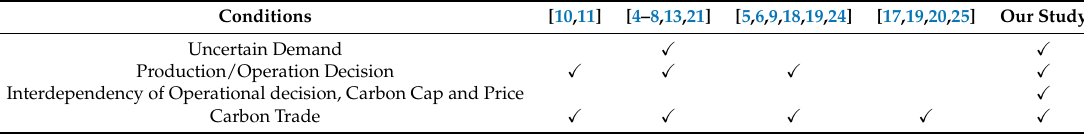
Table 1. Comparison with other